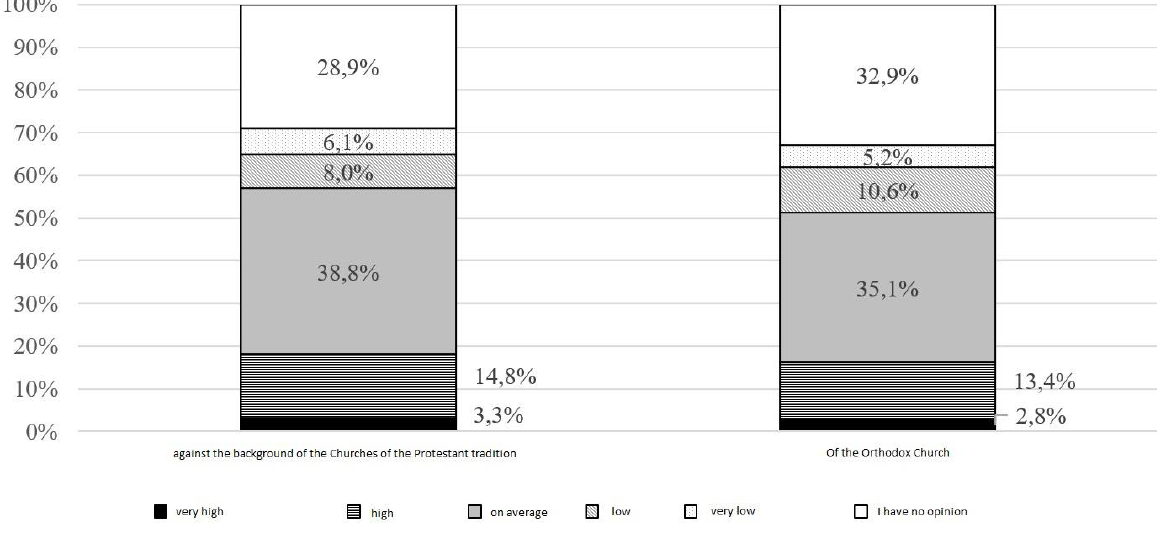
Figure 3. Assessment of the image of the Catholic Church in Poland as compared to other churches. Source: authors’ own elaboration.